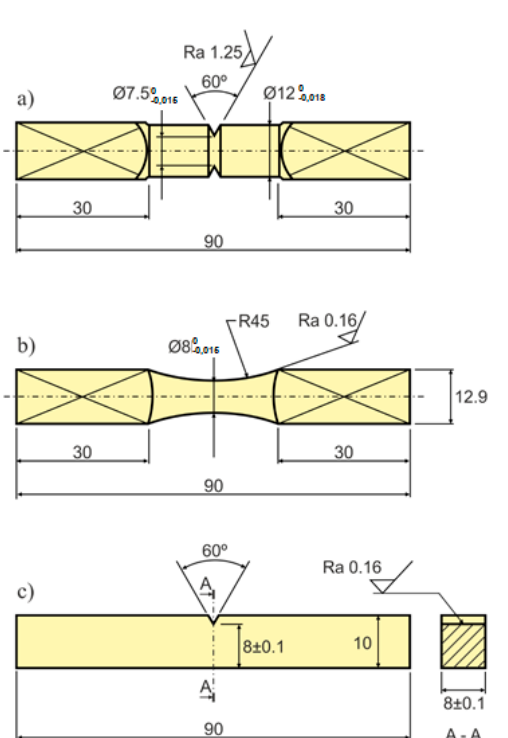
Figure 1. Specimen geometries: ( a ) V-notched circular cross section specimen made of 10HNAP steel; ( b ) smooth circular cross section specimen made of S355J2 steel; and ( c ) V-notched rectangular cross section specimen made of AW-2017A-T4 aluminium alloy (dimensions in millimetres).